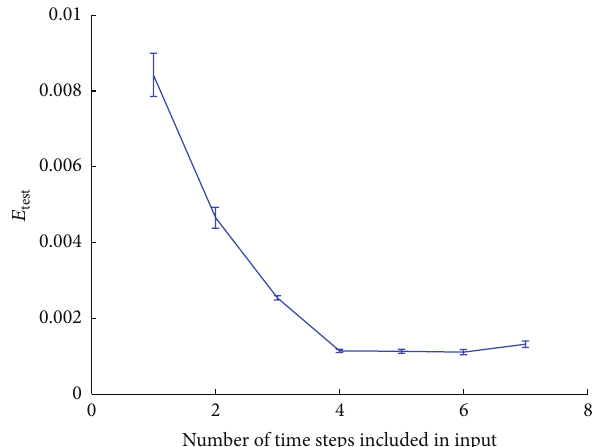
Figure 7: Validation error as function of model memory.